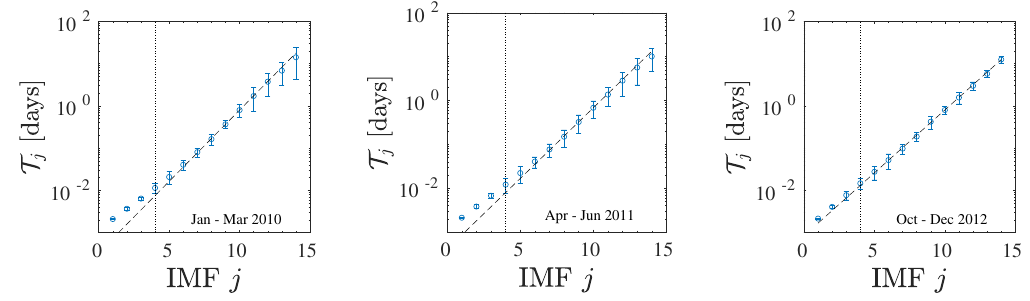
Figure 5. Log-linear plot of the average IMF period as a function of the mode j for three samples; error bars show 95% confidence bounds. The dashed lines represent the relation (7), with γ = 2.10 ± 0.05, γ = 2.05 ± 0.06, and γ = 1.95 ± 0.11,